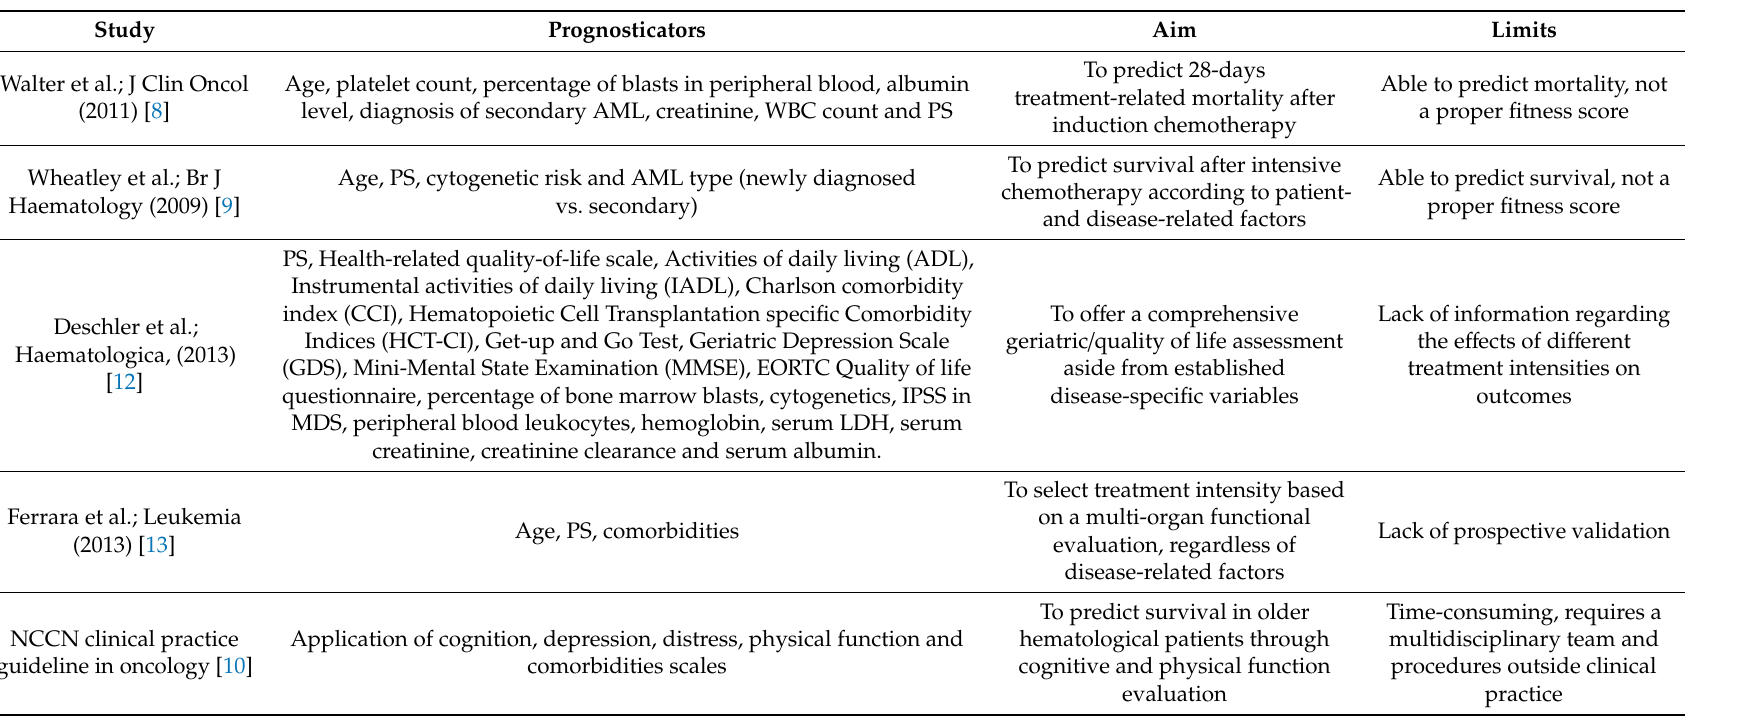
Table 1. Prognostic algorithms for fitness